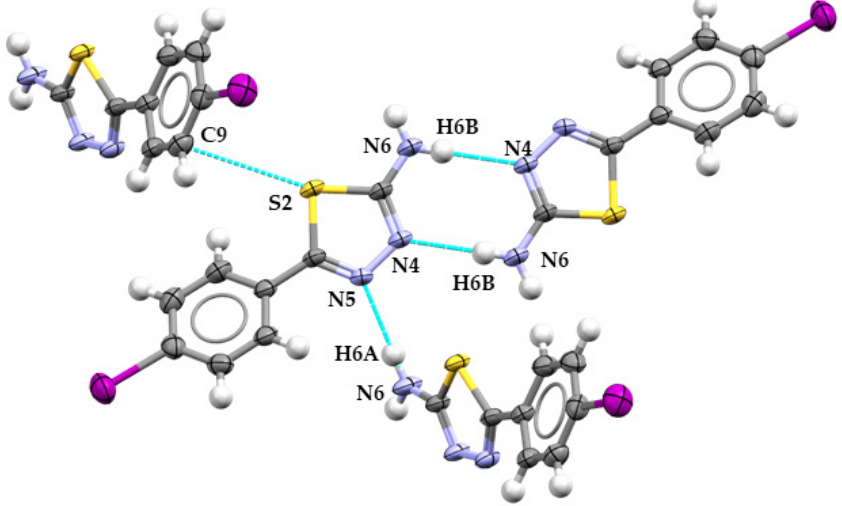
Figure 7. Primary intermolecular contacts in the crystal structure of T1-S-I, Form II.